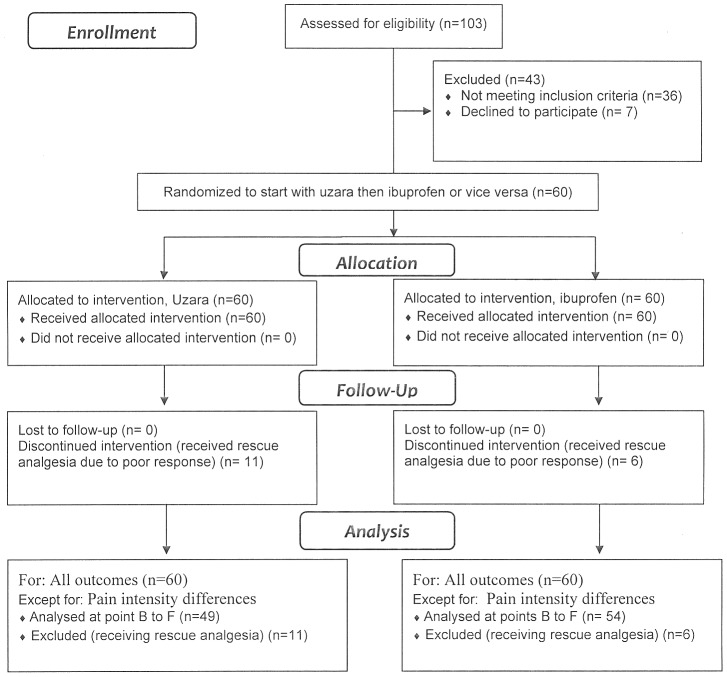
Flow-Chart of study participants.